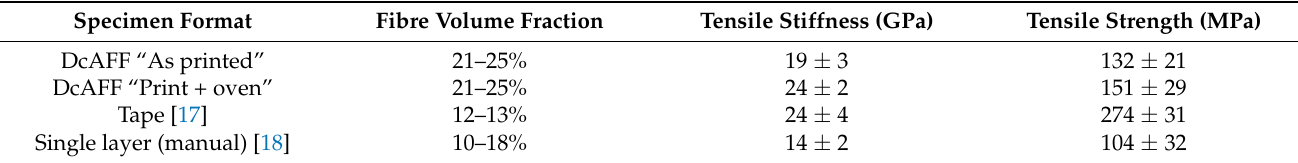
Table 2. Tensile properties comparison of the current DcAFF samples to the previous